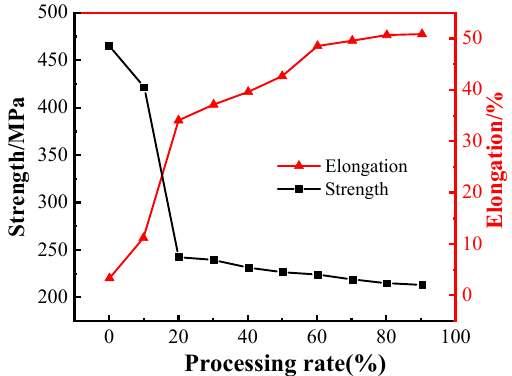
Figure 11. Variation curve of tensile strength and elongation of Ag-4Pd wire during cold defor- mation [145]. Reproduced with permission from Ref. [145]; published by Journal of Mechanical Engineering,